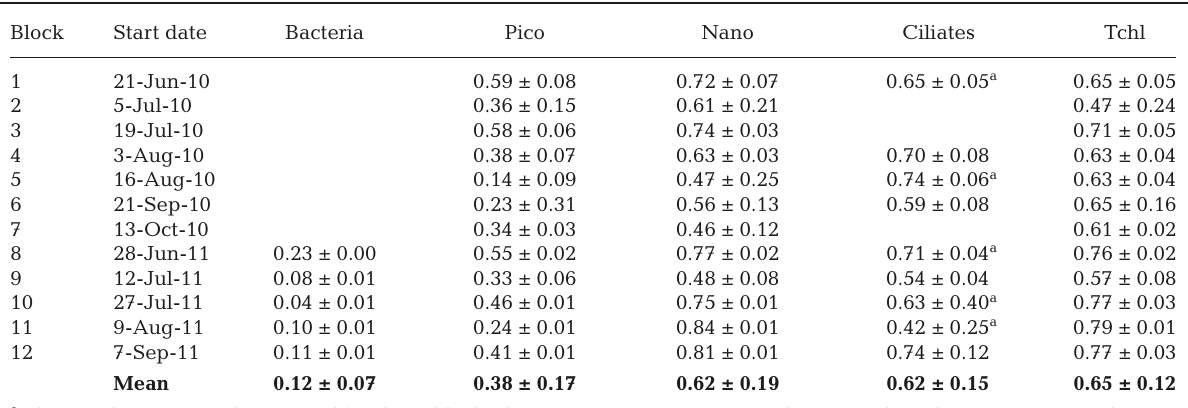
Table 3. Fraction of plankton cells (means ± SD) removed by blue mussels Mytilus edulis (Eq. 2) for bacteria, picophytoplank- ton, nano phytoplankton and total chlorophyll (Tchl). Bacteria removal was only measured in 2011; empty cells indicate that losses were not determined for that